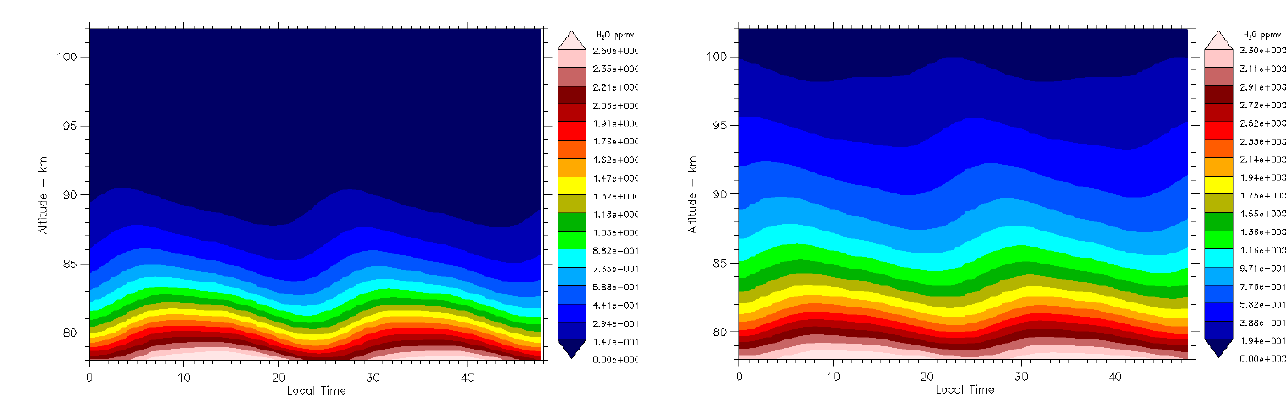
Fig. 1a. H 2 O profiles for model days seven through eight for April equatorial conditions. The model initial conditions are from the ACE-FTS occultation measurements. The effect of the diurnal tide is apparent.